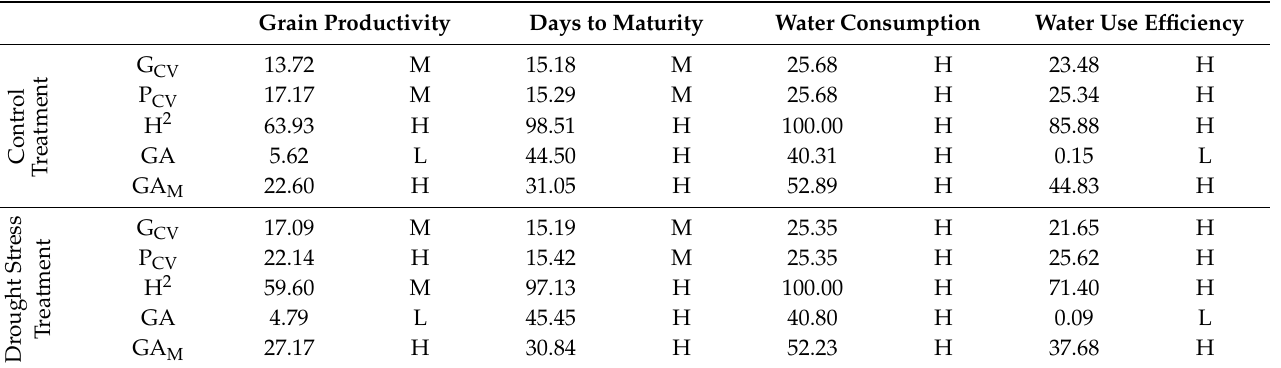
Table 3. Genotypic (G CV ) and phenotypic (P CV ) coefficient of variations, broad-sense heritability (H 2 ), genetic advance (GA) and genetic advance as percentage of mean (GA M ) among grain productivity, days to maturity, water consumption and water use efficiency of lowland rice cultivars under control and drought stress